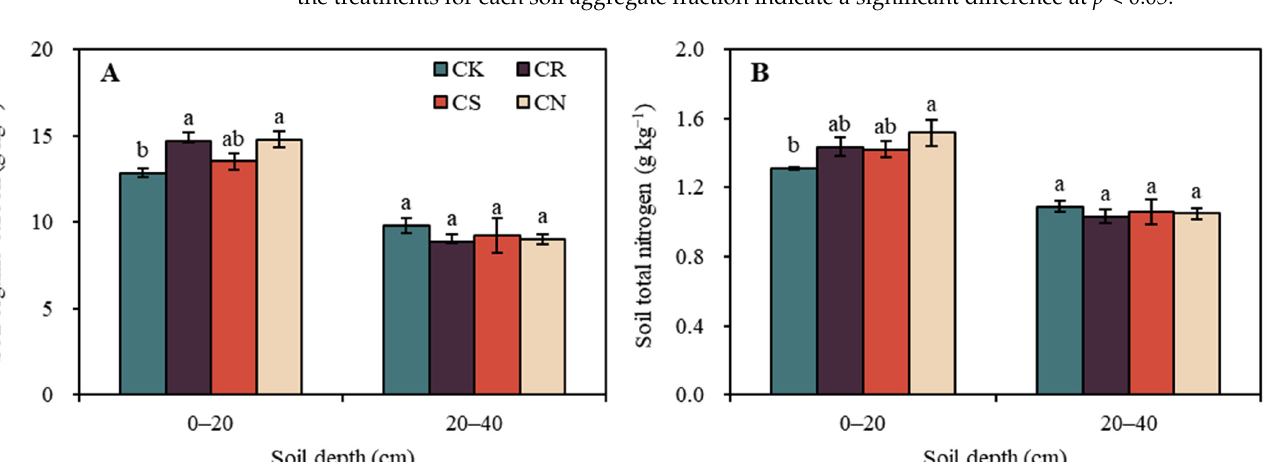
Figure 7. Soil organic carbon content for different soil aggregate fractions at the 0–20 cm ( A ) and 20–40 cm ( B ) soil depths and soil total nitrogen content for different soil aggregate fractions at the 0–20 cm ( C ) and 20–40 cm ( D ) soil depths as affected by tillage regimes in 2021. CK, rotary tillage without straw returning; CR, rotary tillage with straw incorporation; CS, subsoiling tillage with straw mulching; CN, no tillage with straw mulching. Bar means the standard error. Different letters among the treatments for each soil aggregate fraction indicate a significant difference at p < 0.05.